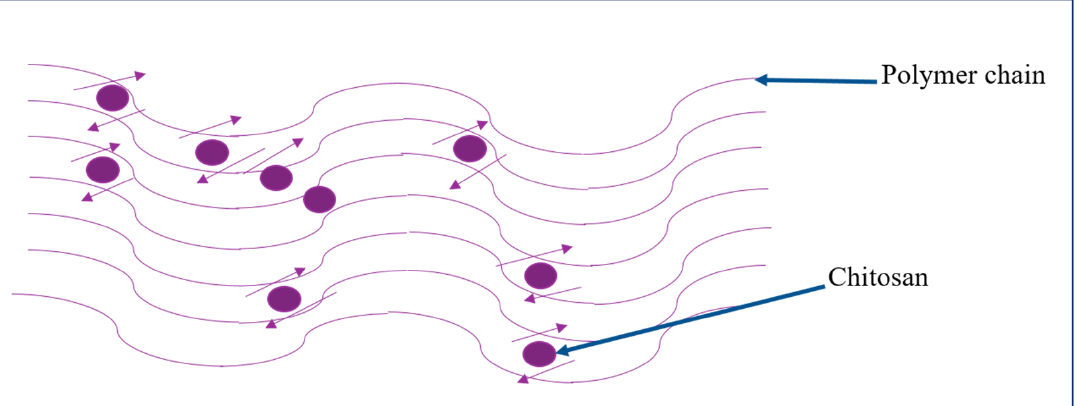
Figure 2. Schematic representation of the slippage of the polymeric chain on/around chitosan